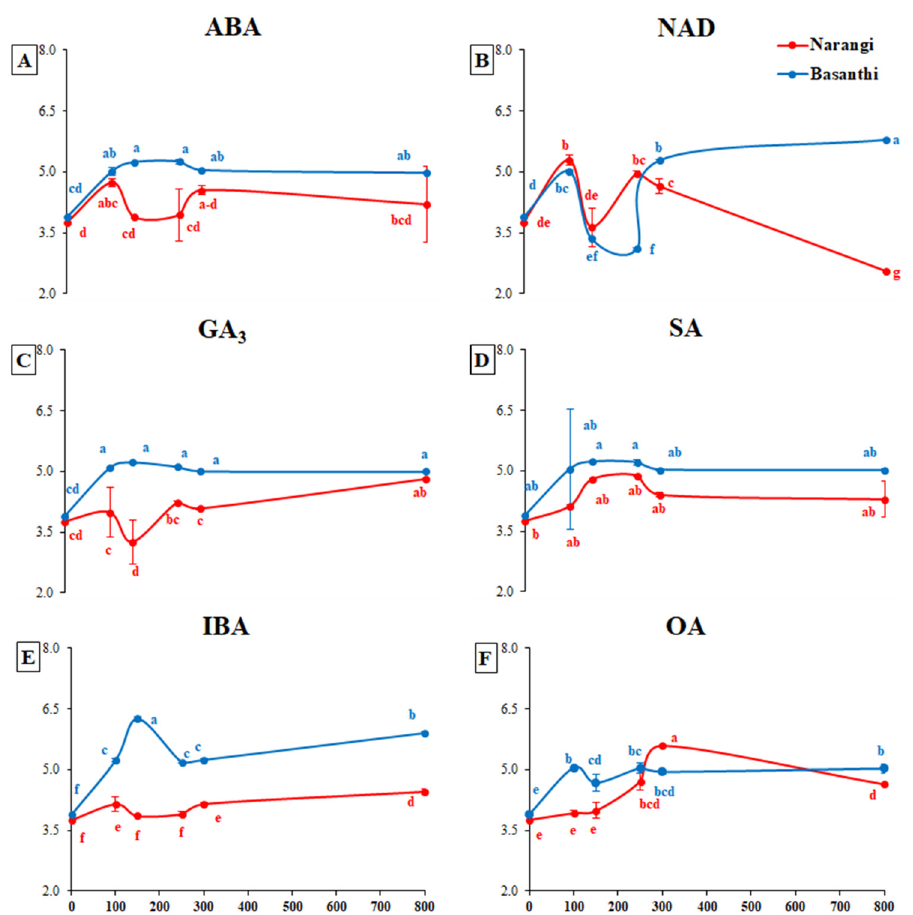
Figure 2. Floral diameter (cm) of two cultivars of marigold (“Pusa Narangi Gainda” and “Pusa Basanthi Gainda”) as affected by different doses (mg · L − 1 ) of ABA ( A ); NAD ( B ); GA 3 ( C ); SA ( D ); IBA ( E ) and OA ( F ). Same letters indicate non-significant difference among treatments under Fisher’s least significant difference test ( p ≤ 0.05). Vertical bars indicate average ± standard error (three replications, under bi-factorial